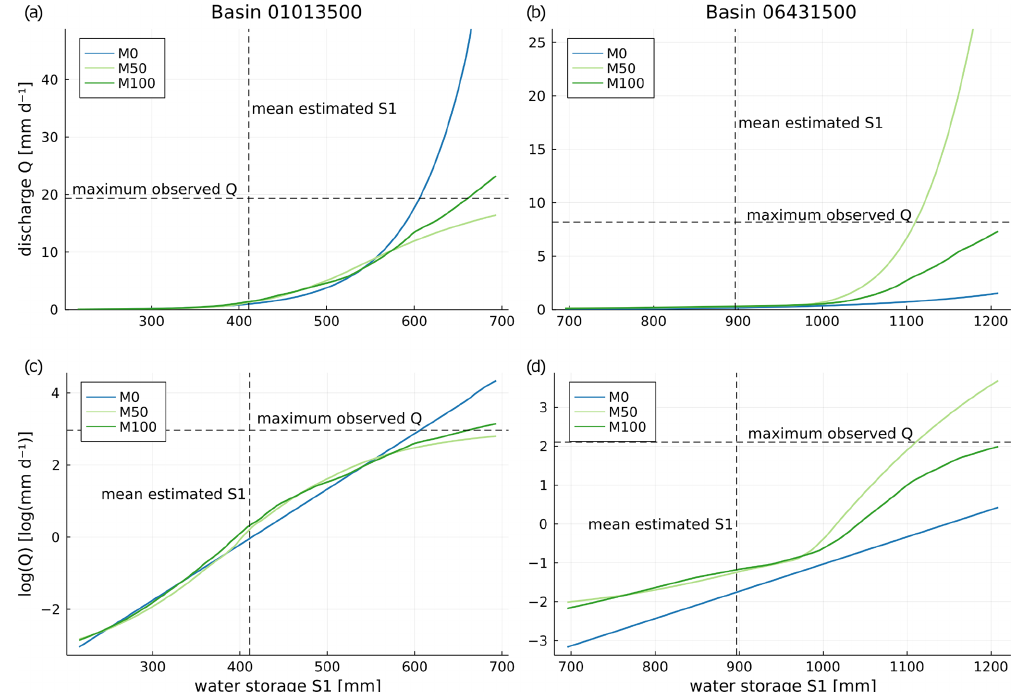
Figure 4. Relation between water storage and discharge (a,b) or logarithmic discharge (c,d) in basin 1013500 (left) and basin 6431500 (right) for models M0 (hard-coded relation), M50 and M100 (learned by a neural network, with additional neural network input snow storage fixed at 0 for both M50 and M100 and both precipitation and temperature fixed at basin averages over the training period).